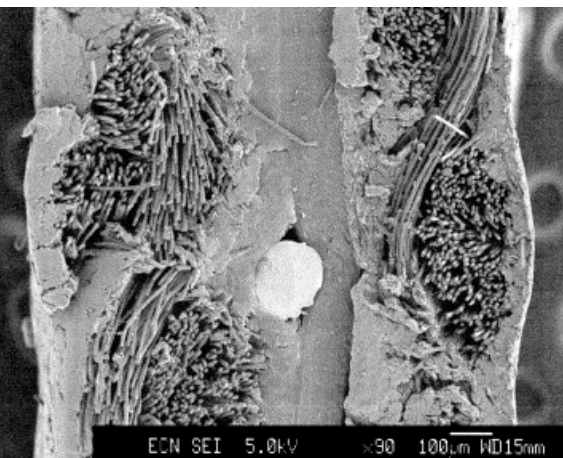
Figure 4. MEA cross section for in situ measurement according to Makkus (Au wire placed between membrane and E-tek backing plus electrode). Reprinted from [64] copyright (2000), with permission from Elsevier.